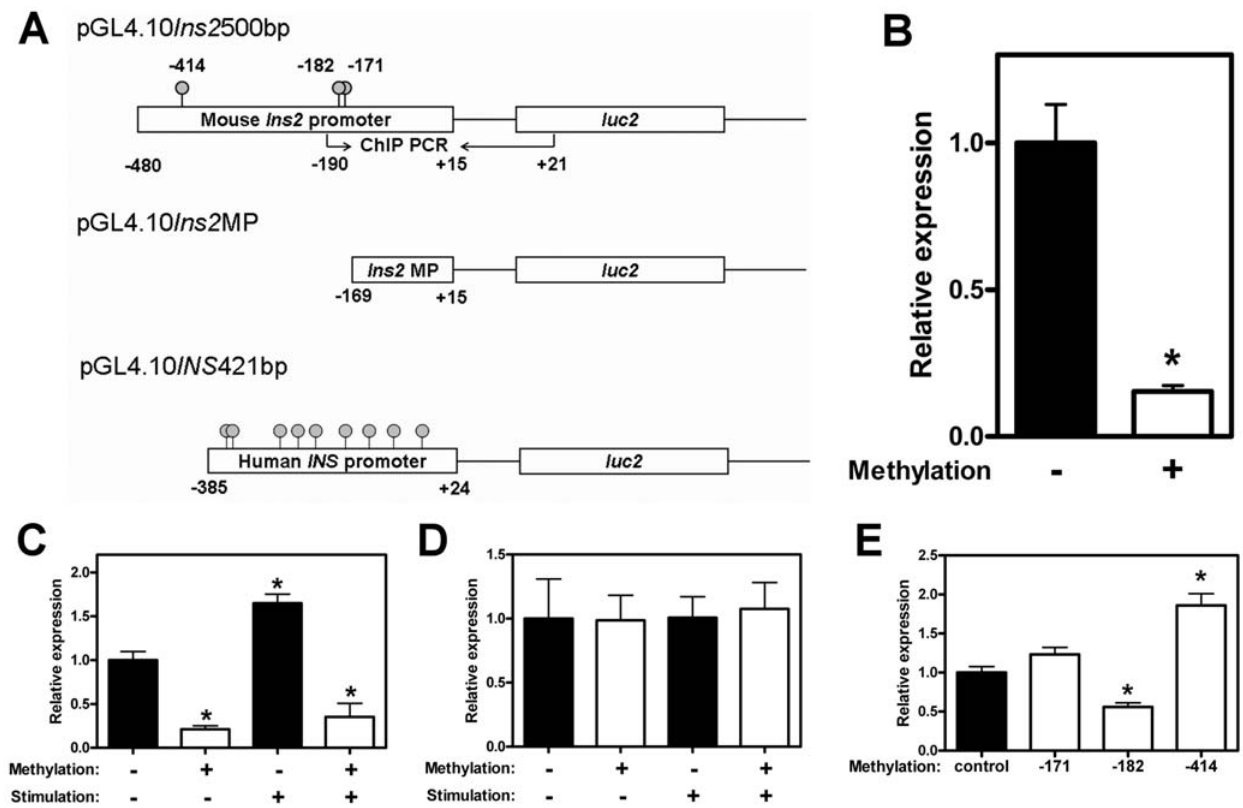
Figure 2. Methylation suppresses the activity of both the mouse and human insulin gene promoters. (A) A diagram of the three luciferase reporter plasmids used to test the effect of methylation on insulin promoter activity. PGL4.10 Ins2 500bp contains bases 2 480 to + 15 (three CpG sites) of the Ins2 gene, pGL4.10 Ins2 MP contains bases 2 169– + 15 bp (no CpG sites), and, pGL4.10 INS 421bp contains bases 2 385 to + 24 of the human INS gene (nine CpG sites). The positions of CpG dinucleotides are represented with ‘‘lollipop’’ markers and the positions of primers for the ChIP experiments by arrows. (B) Methylated (white bar) or mock-methylated (black bar) human INS promoter constructs were transfected into NIT-1 insulinoma cells 48 hours prior to the luciferase assay. The data were normalized with co-transfected control vector and are the average and standard error from three separate experiments of eight replicates each. Data are presented as relative expression compared with the non-methylated, non- stimulated sample. *=p , 0.0001 (C) Methylated (white bars) or mock-methylated (black bars) mouse Ins2 promoter constructs were transfected into NIT-1 insulinoma cells and stimulated for four hours with 2.8 mM glucose (Stimulation -) or with 16.7 mM glucose and 10 m M forskolin (Stimulation + ). The data were scaled to the unmethylated, unstimulated control. The results are the average and standard error from three separate experiments of eight replicates each. *=p , 0.0001 compared with control. (D) The minimal Ins2 promoter construct was treated and analyzed as in 1C. There was no significant effect of methylation or stimulation on minimal promoter activity (one-way ANOVA p=0.9928). (E) The mouse Ins2 promoter construct was methylated individually at each CpG site (white bars) or mock-methylated (black bar) and then transfected and analyzed as in 1B. The results are the average and standard error from three to five experiments of eight replicates each. *=p , 0.0001 compared with